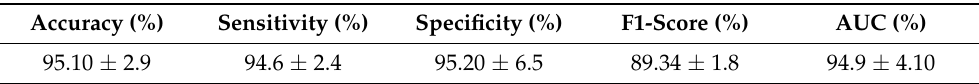
Table 7. Performance measures of the ECG-trained model on UMass-DB PPG signals after transfer learning folds expressed as mean and standard deviation.